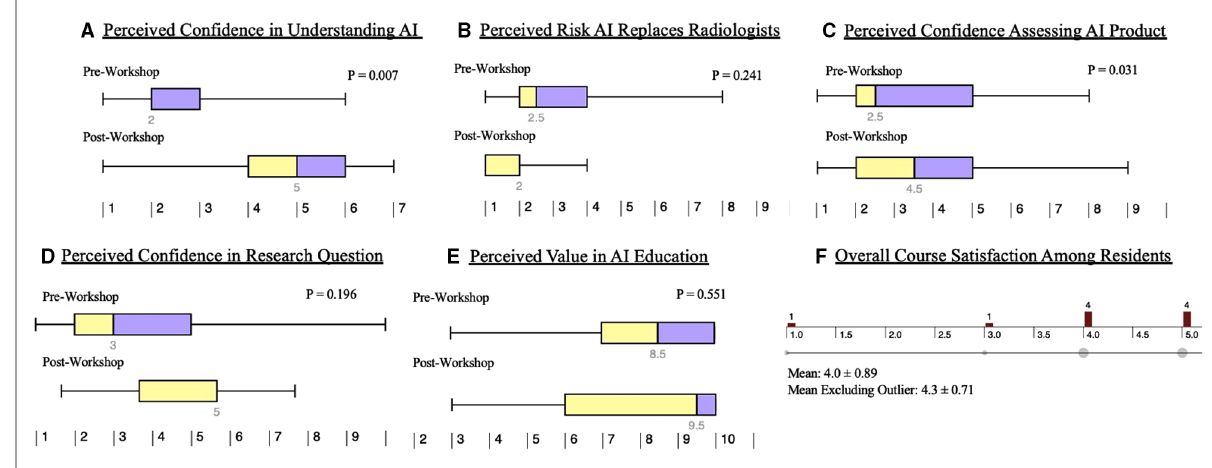
FIGURE 3 Learner perceptions of arti fi cial intelligence before and after AI-RADS. The results of the pre and post workshop survey are summarized as above. There were signi fi cant increases in perceived con fi dence understanding arti fi cial intelligence ( A ) as well as assessing arti fi cial intelligence related products ( C ). Residents had a nonsigni fi cant decrease in their perception of AI ultimately replacing radiologists ( B ). There was a non-statistically signi fi cant increase in perceived con fi dence in formulating an AI-related research question ( D ). The workshop garnered an average satisfaction rating of 4.0/5 ( F ); exclusion of the outlier resulted in an average of